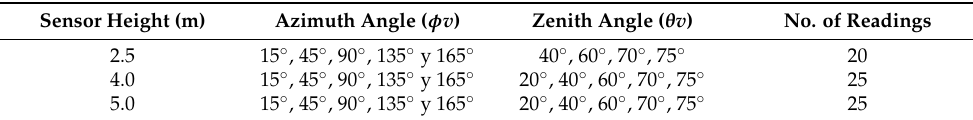
Table 2. Geometric parameters used for the measurement of radiative temperature and albedo.